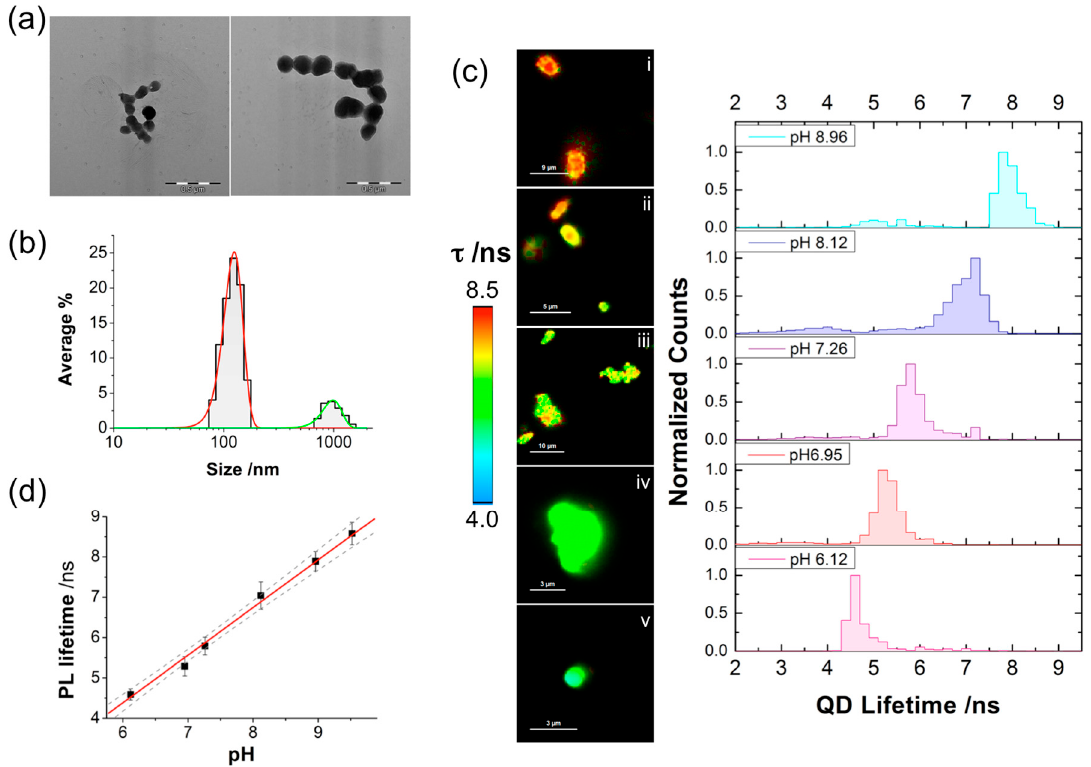
Figure 1. ( a ) TEM images of QD-SS20-MPA. Scale bars correspond to 0.5 µm. ( b ) The particle size distribution of QD-SS20-MPA suspended in phosphate buffer at pH 8.0. The distribution is the average of three independent measurements. ( c ) Representative fluorescence lifetime imaging microscopy (FLIM) images and photoluminescence (PL) lifetime distributions of QD-SS20-MPA nanosensors on glass slides suspended in intracellular cell buffer at different pH values: i) 8.96; ii) 8.12; iii) 7.26; iv) 6.95; and v) 6.12. The images were selected from a set of 10 different images at each pH. Scale bars correspond to 9 (i), 5 (ii), 10 (iii), 3 (iv), and 3 µm (v). The corresponding normalized PL lifetime distributions are the average of 10 different pictures of different fields of view. ( d ) PL lifetime versus pH calibration obtained from FLIM images from QD-SS20-MPA nanosensors on glass slides. Black squares represent the center of the PL distributions, as obtained by fitting the distribution to a Gaussian function, and error bars represent the associated error of the fitting. The red line is the linear fitting of the data ( r 2 = 0.994), whereas the dashed lines represent upper and lower confidence limits of the fitting at 95% confidence.